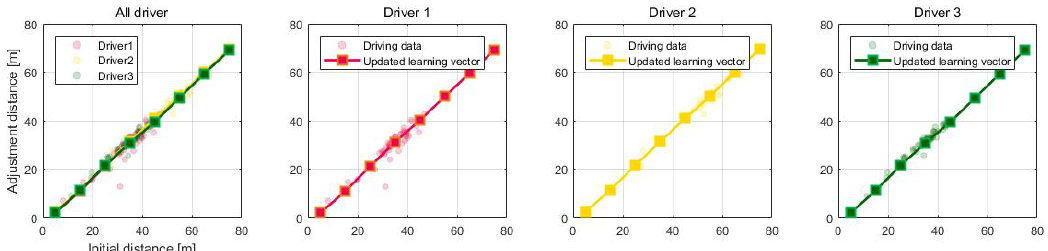
Figure 21. Learning results of learning vector for adjustment distance.